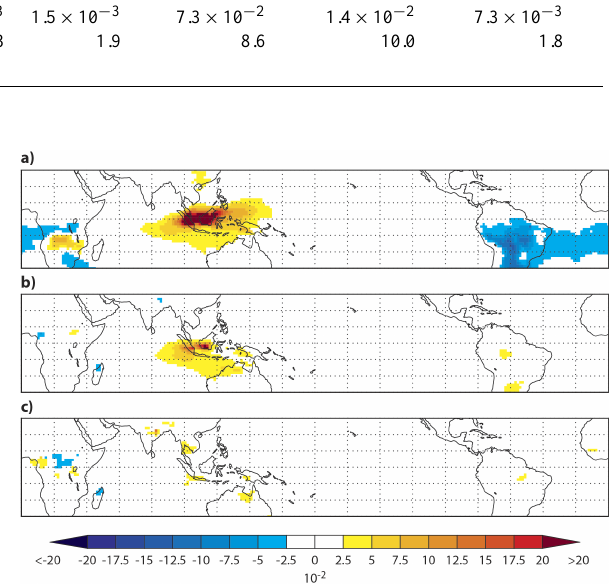
Figure 6. The same as Fig. 5 but for CO anomaly at 500hPa in ppb.